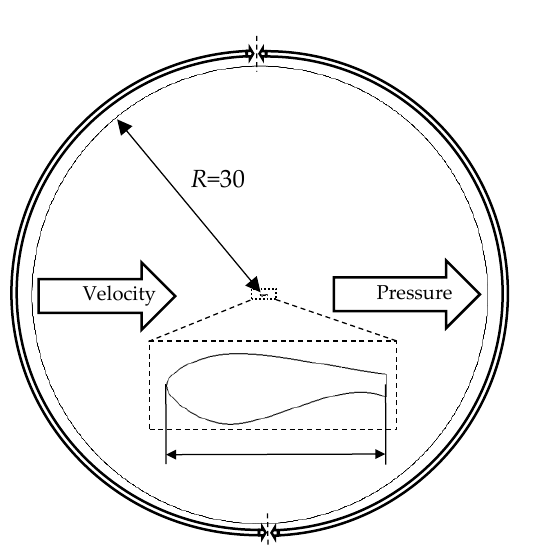
Figure 2. Computational domain size and boundary condition.